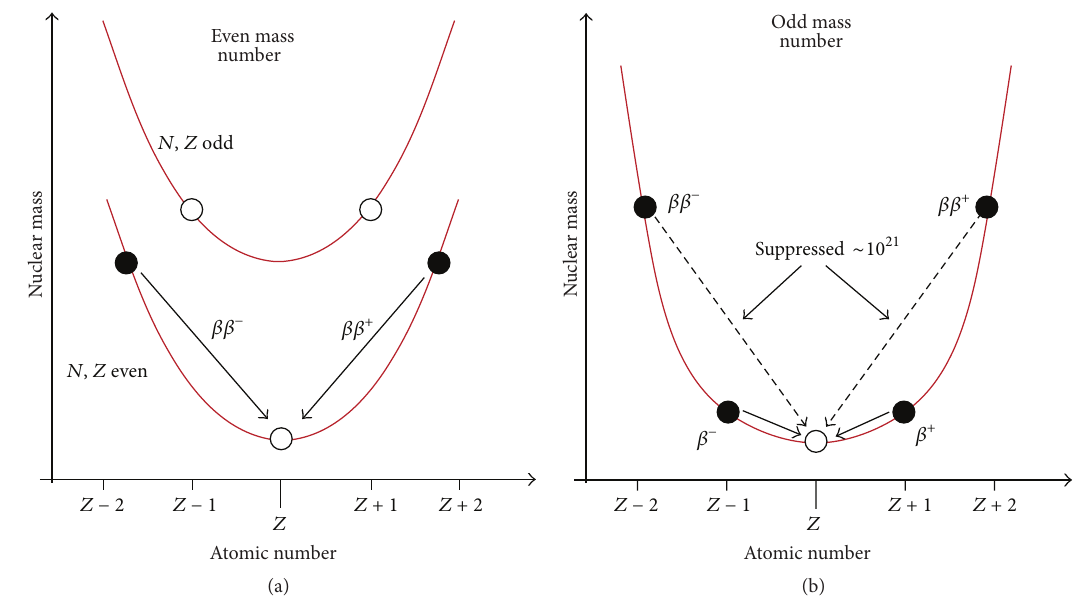
Figure 9: Nuclear mass as a function of the atomic number 𝑍 in the case of an isobar candidate with 𝐴 even (a) and 𝐴 odd (b).